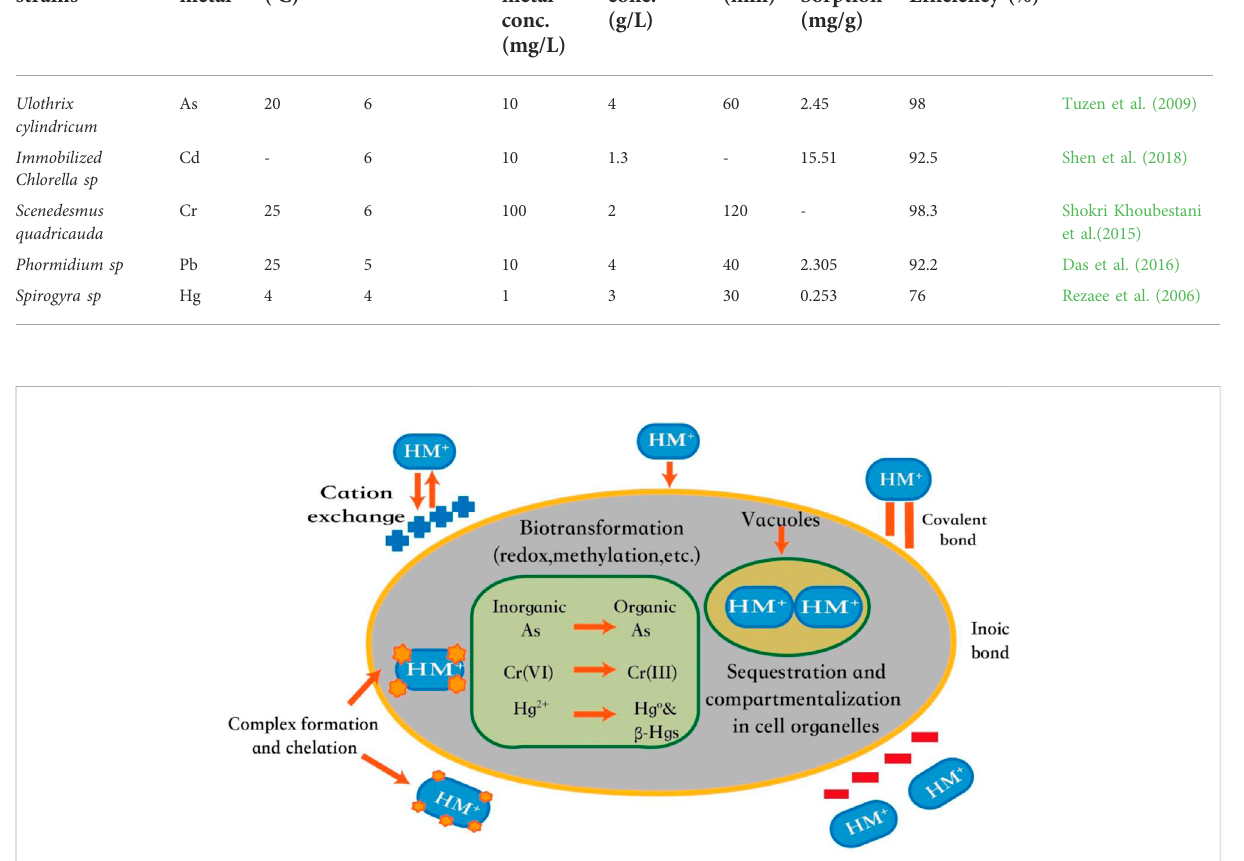
FIGURE 2 Mechanism of Removal of Heavy Metals by Microalgae. Adapted with the permission from ELSEVIER (Leong and Chang,